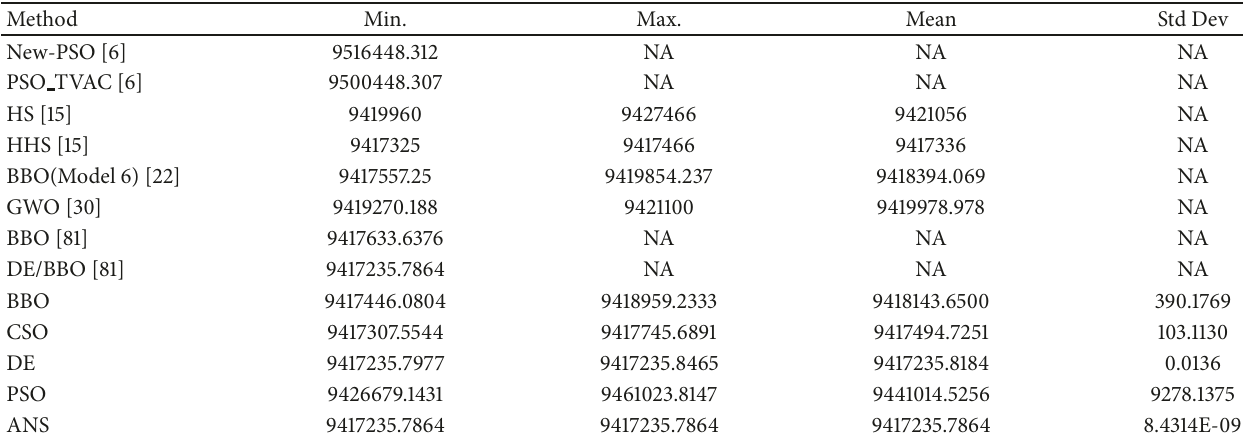
Table 4: Comparison of simulation results ($/h) for 38-generator system (Case